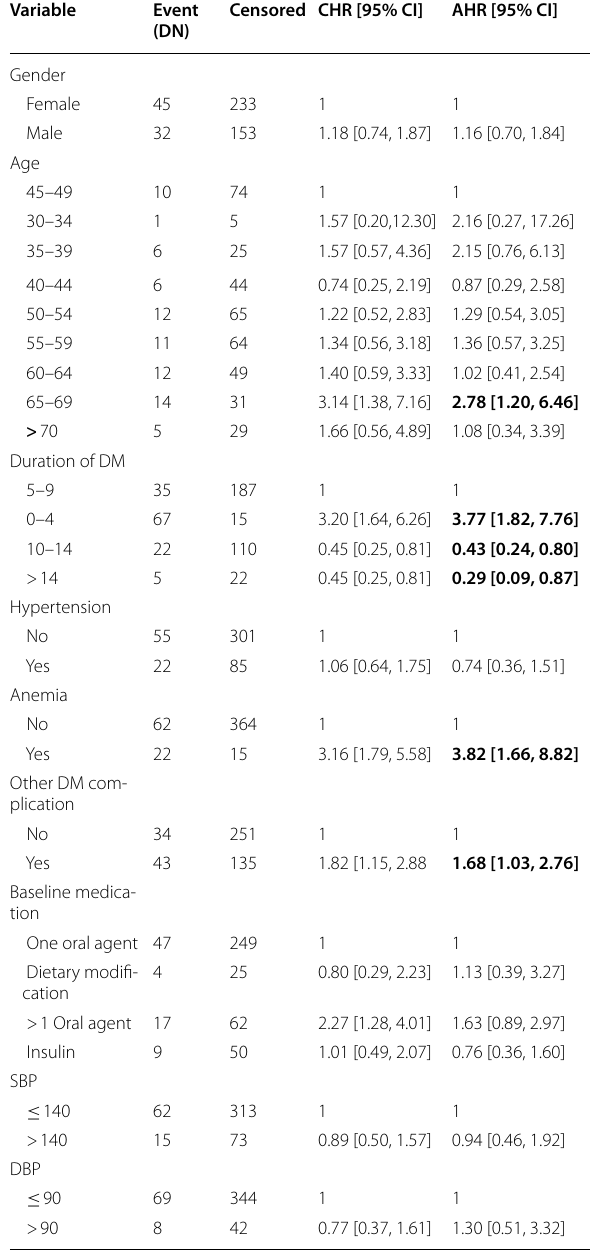
Table 2 Predictors of time to diabetic neuropathy among newly diagnosed T2DM patients in UGCSH, January